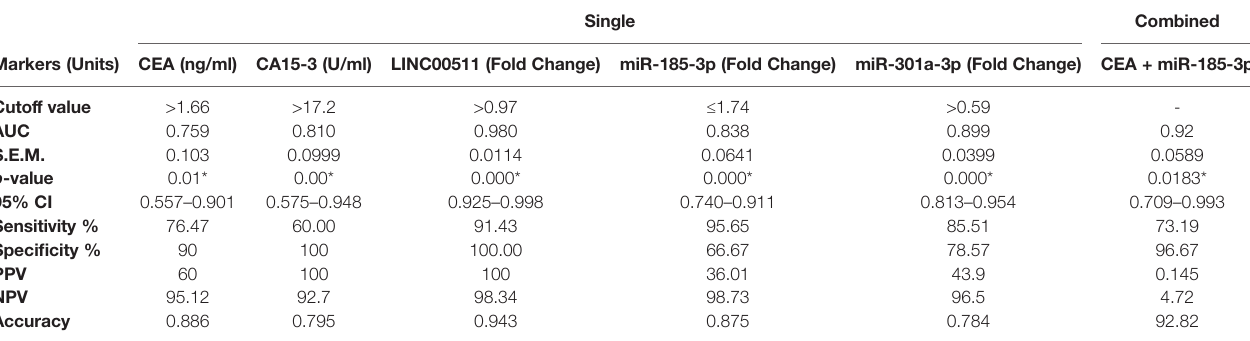
TABLE 3 | Overall sensitivities, speci fi cities, and predictive values for the tested markers (molecular; ncRNAs and protein TMs) in BC patients ( n = 70) single or combined. Single Combined